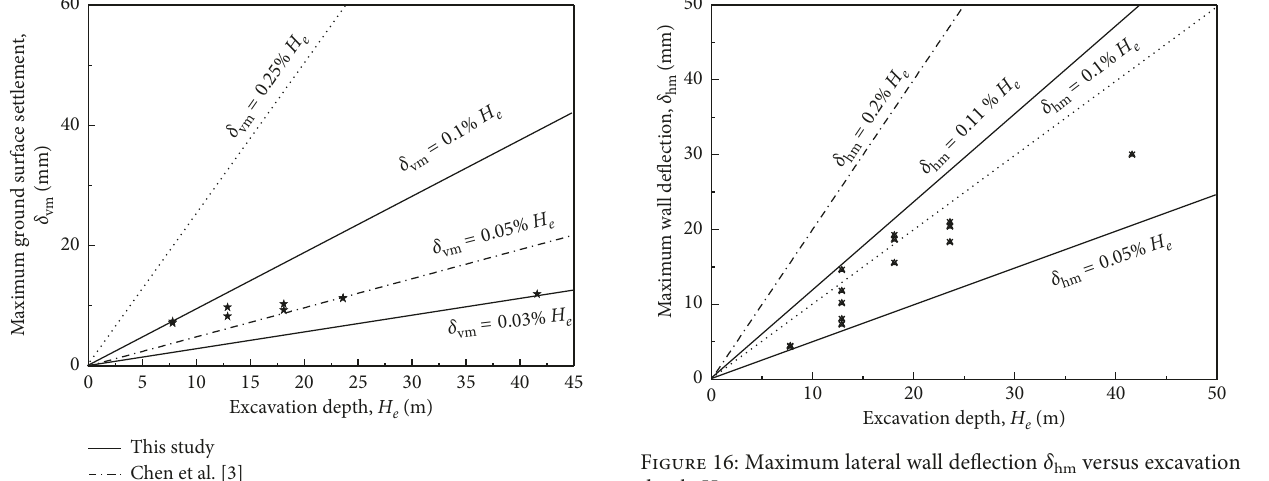
hm versus excavation